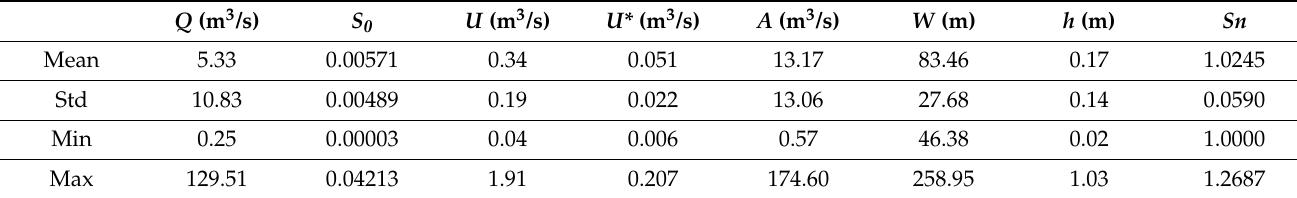
Table 4. Statistics of the estimated hydraulic and geometry variables of 48 sub reaches from HEC-RAS model simulations according to the streamflow scenarios in Gam Creek.